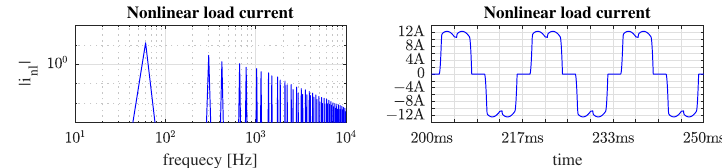
Figure 13. Nonlinear load current: FFT results and waveform.